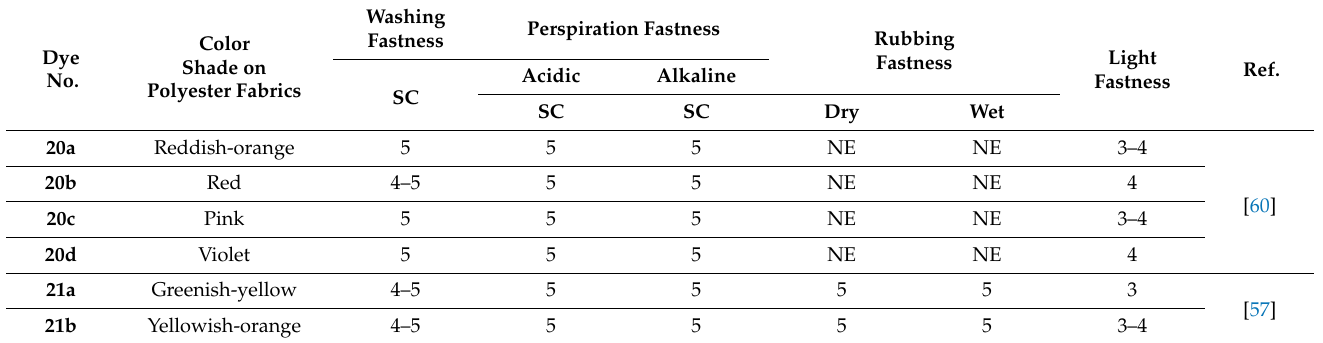
Table 4. Antitumor and antioxidant activities of disperse dyes 18h and 18i. Dye No.